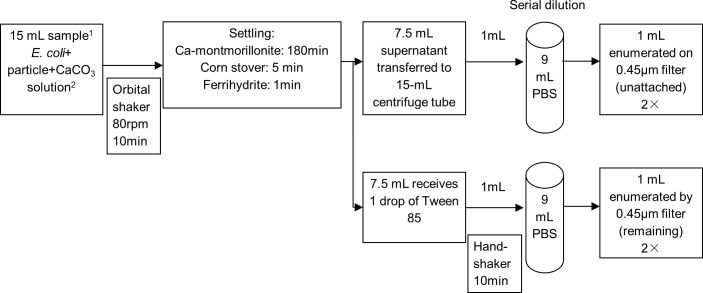
Flow chart describing the attachment assay.1. E. coli concentration: 103 cfu/ mL; Ca-montmorillonite concentration: 108 mg/ mL; Corn stover: 1.06 mg L-1; Ferrihydrite concentration: 1.06 mg/ mL; triplicate samples for each assay. 2. Solute: CaCO3; solvent: autoclaved deionized water. This solution has pH 8, with 10mM as ionic strength.